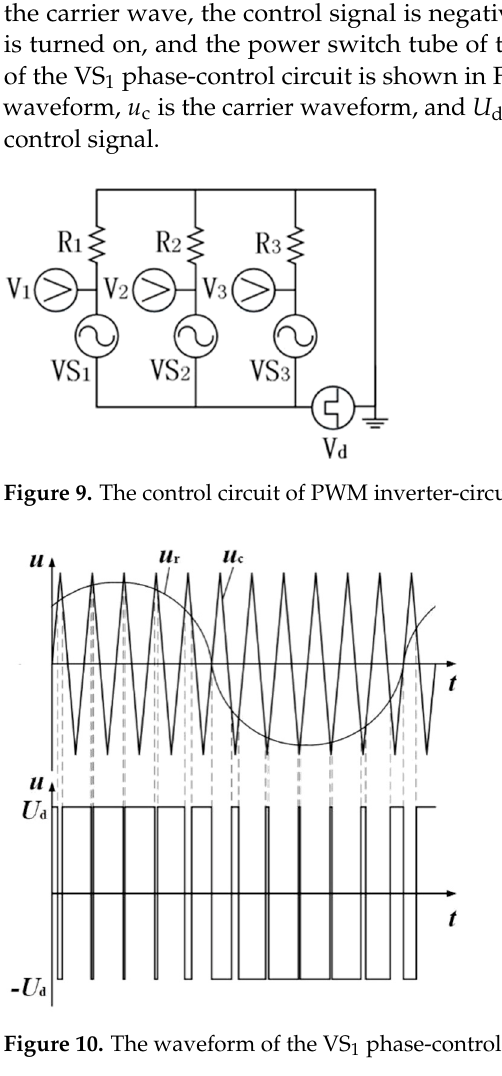
Figure 10. The waveform of the VS 1 phase-control circuit.